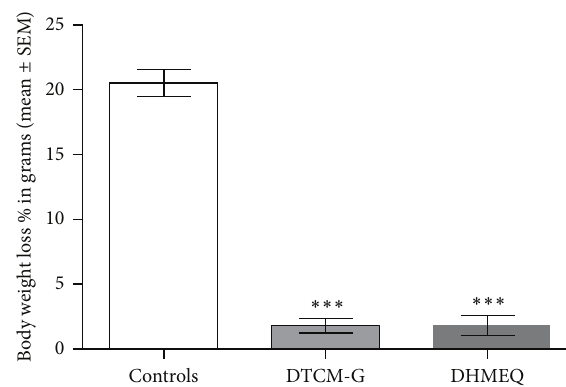
Figure 1: The body weight loss at the end-point of the experiment in controls, DTCM-G-treated, and DHMEQ-treated groups. ∗∗∗ 𝑃 < 0.0001 versus controls.